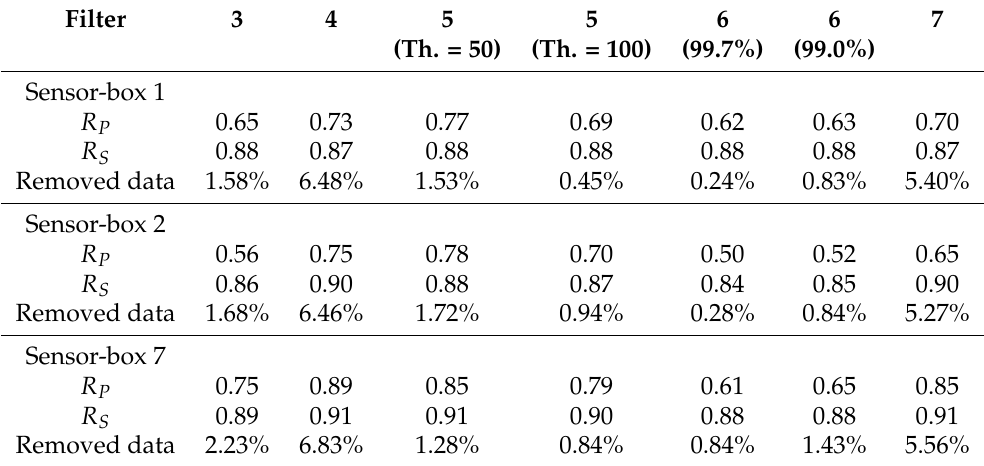
Table A3. Results of sliding window filtering methods applied to raw PM 10 data: correlation between sensor-box and in-luft data versus removed data. Window size = 1000 data